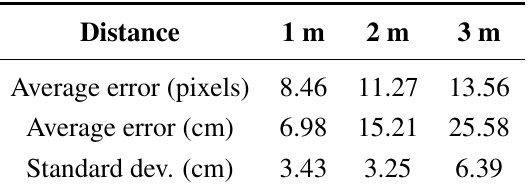
Table 2. Quantitative experiment results of our proposed pointing algorithm with using a laser